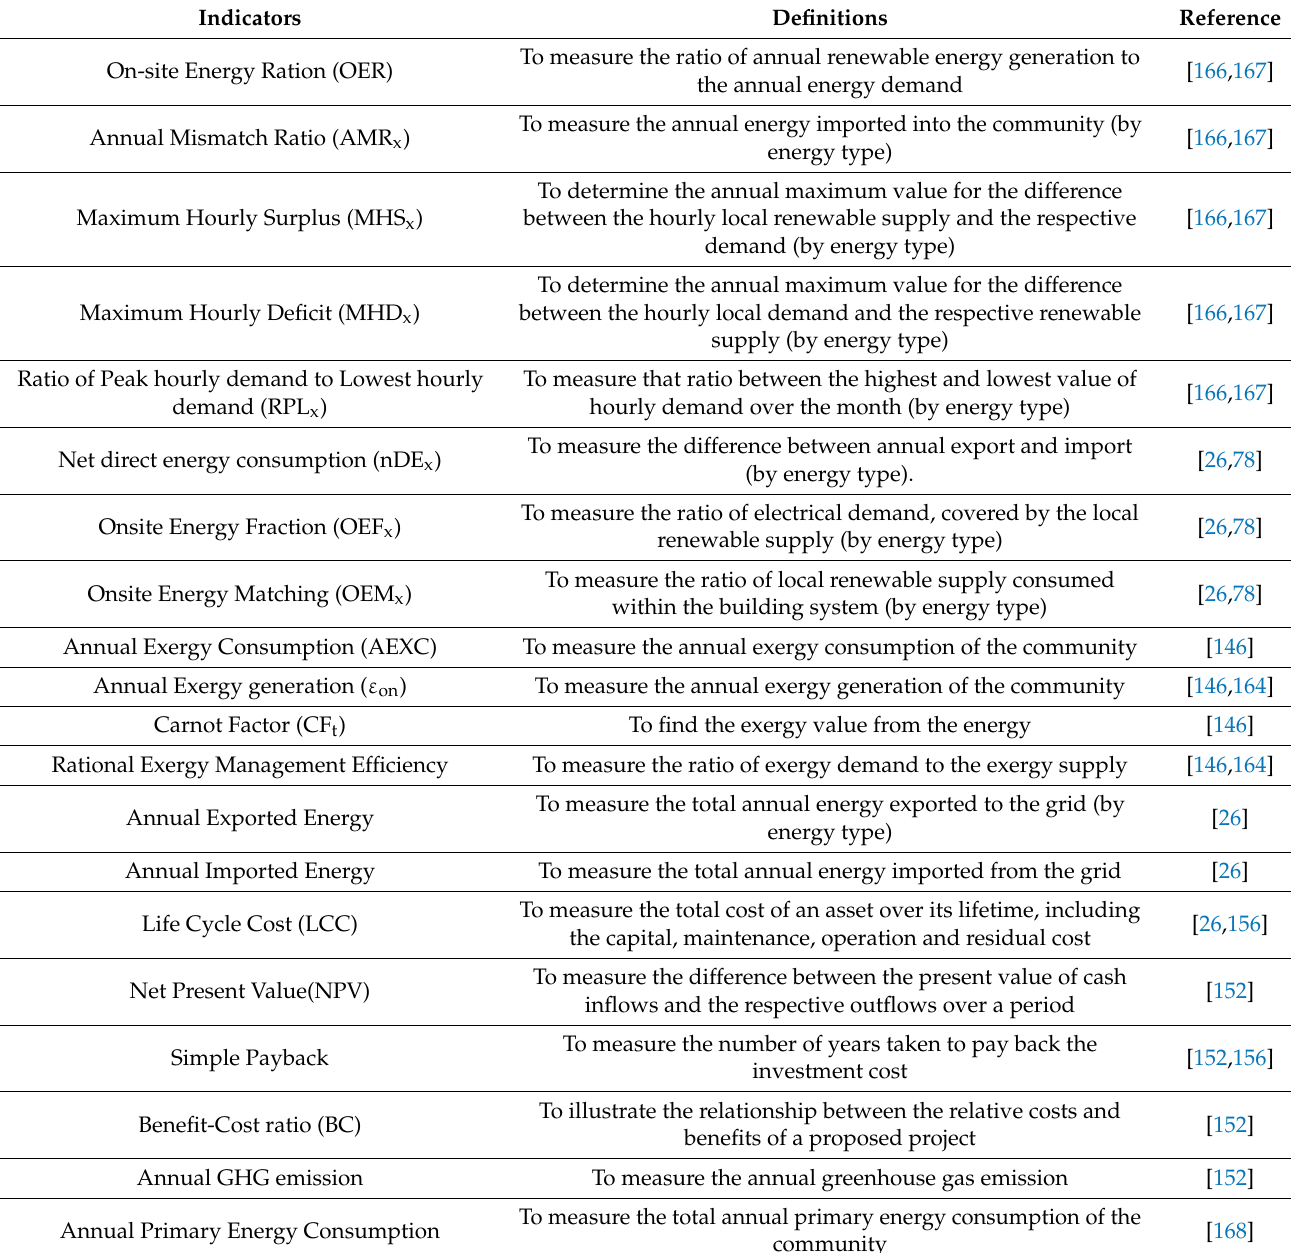
Table 3. Key indicators of the positive energy